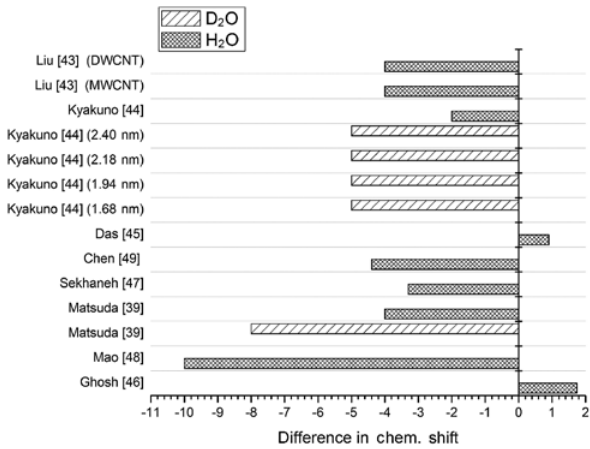
Figure 2: Differences in the reported chemical shifts of confined water (D O or H O) in CNTs. The chemical shifts presented here are 2 2 with respect to the reported chemical shifts of bulk water (D H O) of each sample (column 3 of Table 2). Each value is obtained by 2 the subtraction of the value of column 3 (Table 2) from the corre- sponding value of column